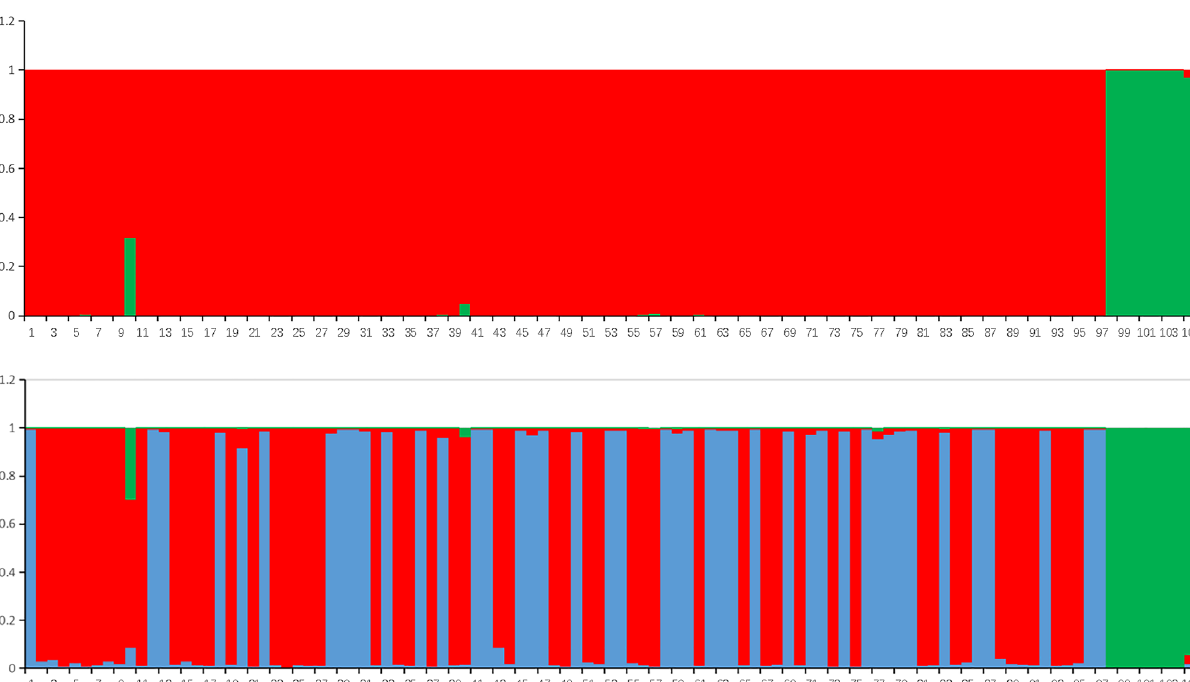
and Shandong Provinces. The accessions that demonstrated a low level of admixture, except “Xushu 18-1”, belonged to Ipomoea batatas (L.) Lam. The model with 3 gene pools was also supported by the STRU CTU RE results. Under this model, group 1 in the K = 2 model was further divided into two gene pools (red and blue), but the other gene pools remained almost the same (Fig. 2). The 3 groups included 53, 44, and 8 sweet potato accessions, respectively. In the K = 3 model, group 1 and group 2 (red and blue) overlapped substantially with one another, and the hierarchical levels in these two clusters could hardly be recognized. All 97 accessions in group 1 and group 2 appeared to be from the two major gene pools. Several accessions from Jiangsu Province showed admixed origins, such as ‘Xushu 18-1’, with three major gene pools. A two-dimensional and three-dimensional PCA (principal component analysis) further depicted the relation- ship among the 105 sweet potato accessions (Fig. 3). In the two-dimensional PCA, Dim-1 and Dim-2 were 1.12 and 0.51, respectively. The Dim-3 was 0.60 in the three-dimensional PCA. From the PCA diagrams, we could